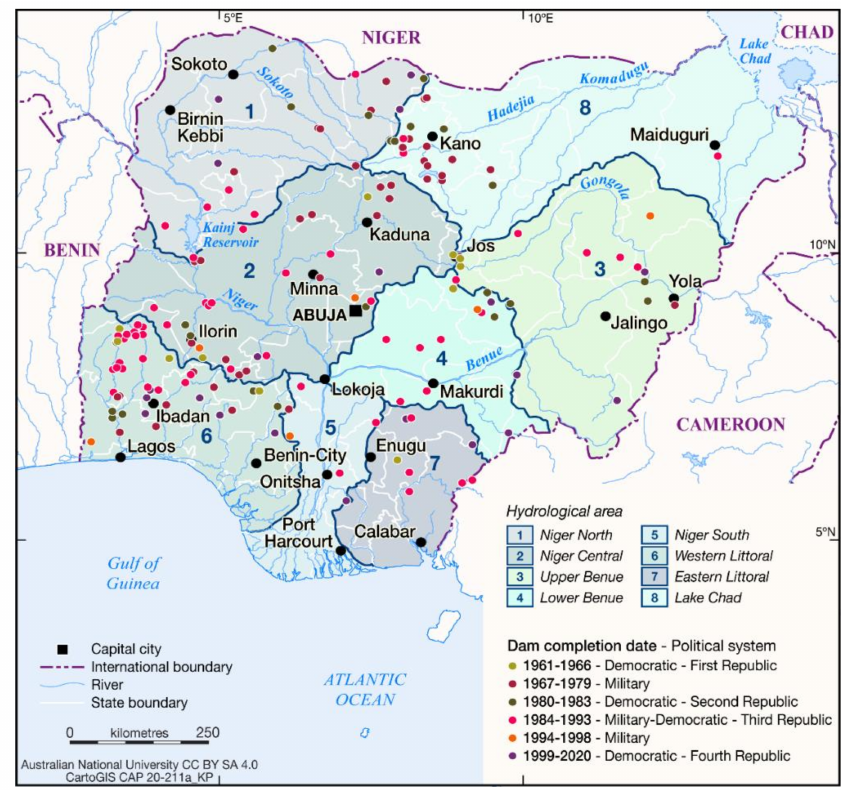
Figure 8. Distribution of completed dams in post-independence Nigeria